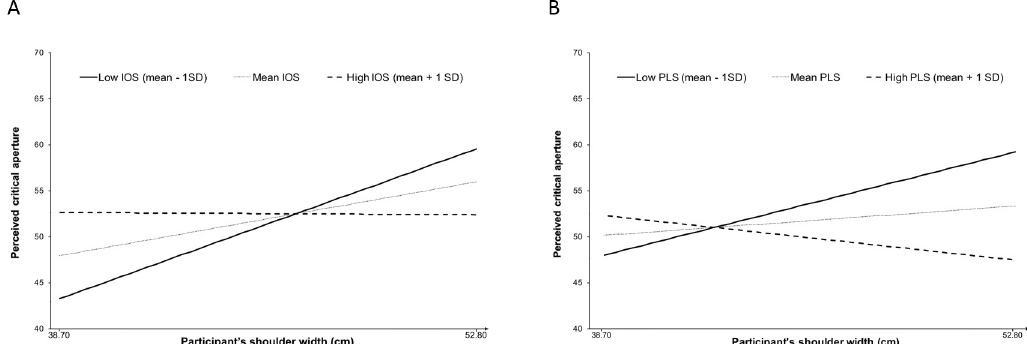
Fig 1. Moderating effects of IOS (A) and PLS (B) scores on the relationship between participants’ shoulder width and perceived critical aperture width in the 1-PP task. A: Shoulder width and IOS scores interactively predict perceived critical aperture in romantically involved participants. Participants’ shoulder width is a significant predictor of perceived critical aperture when IOS scores are small (mean– 1SD), b = 1.226, β = .550, but not when IOS scores are high (mean + 1SD), b = -.037, β = -.016. B: PLS scores also moderate the relationship between shoulder width and perceived critical aperture. This relationship is significant for low PLS scores (mean– 1SD), b = .846, β = .379, but not for high PLS scores (mean + 1SD), b = -.366, β = -.164.